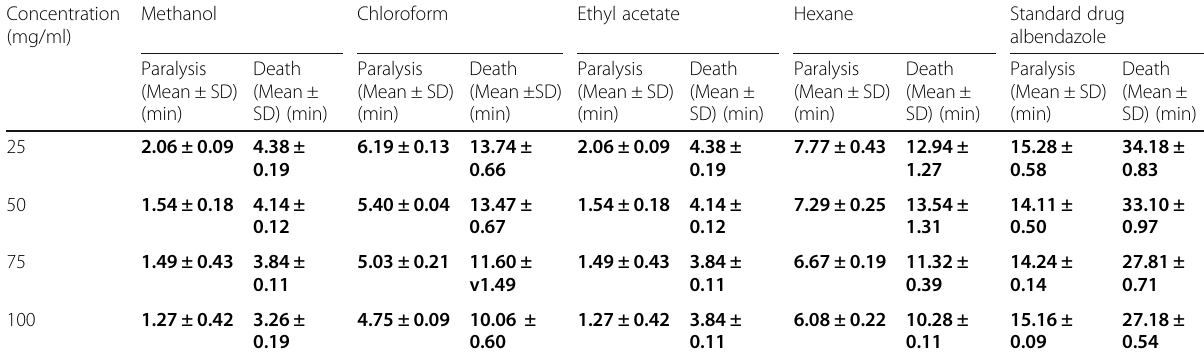
Table 2 Anthelmintic activity with different extracts of C. epigaeus tuber and standard drug Concentration (mg/ml)